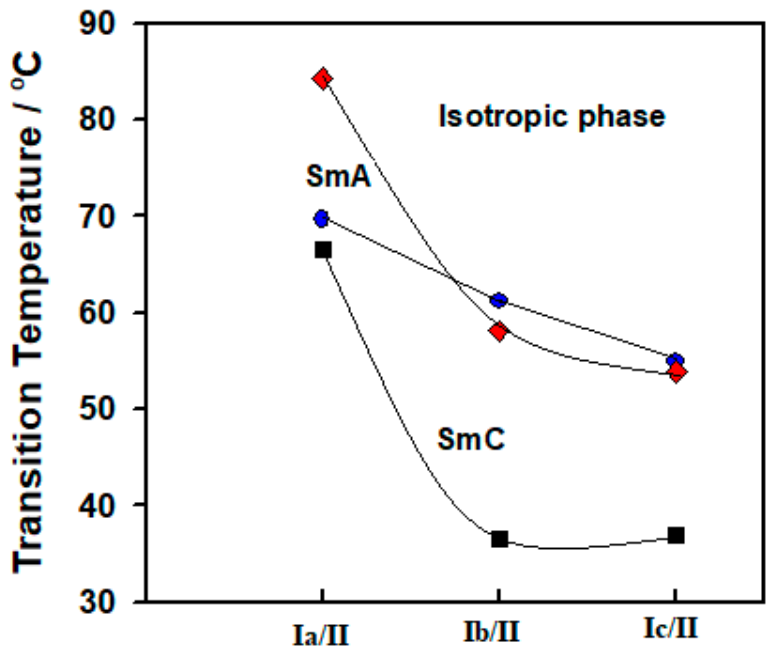
Figure 5. Transition temperatures of designed complexes Ix/II .